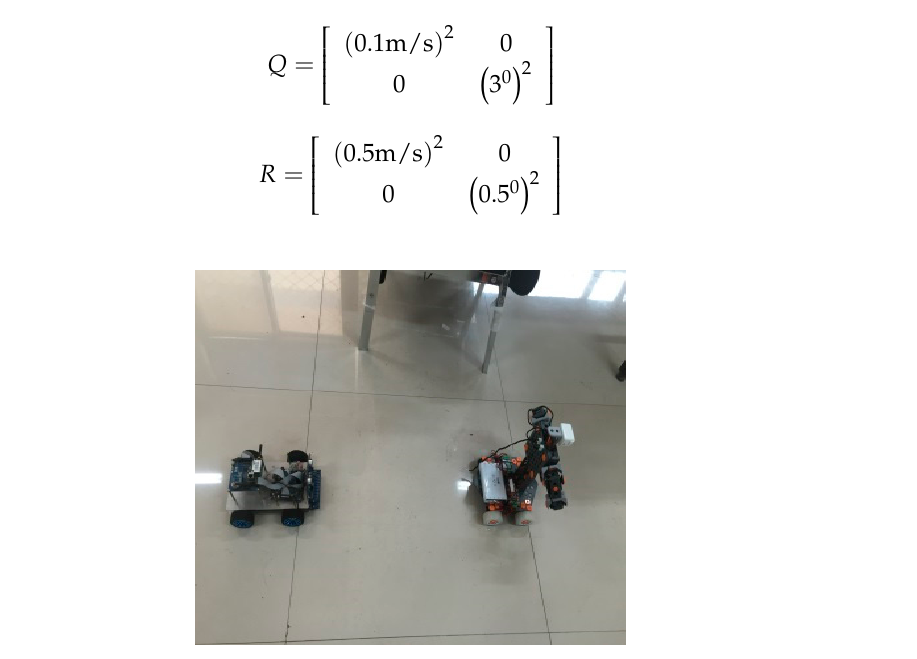
Figure 4. The local enlarged true trajectory and the estimated trajectory for the leader–follower robot team. Figures 5–7 illustrate the comparative error curves of the follower robot by using the traditional EKF method in the first 100 steps and the proposed method in the next 200 steps, respectively. It can be seen that the estimation errors of the proposed algorithm were bounded in a smaller range when compared with the traditional EKF method.